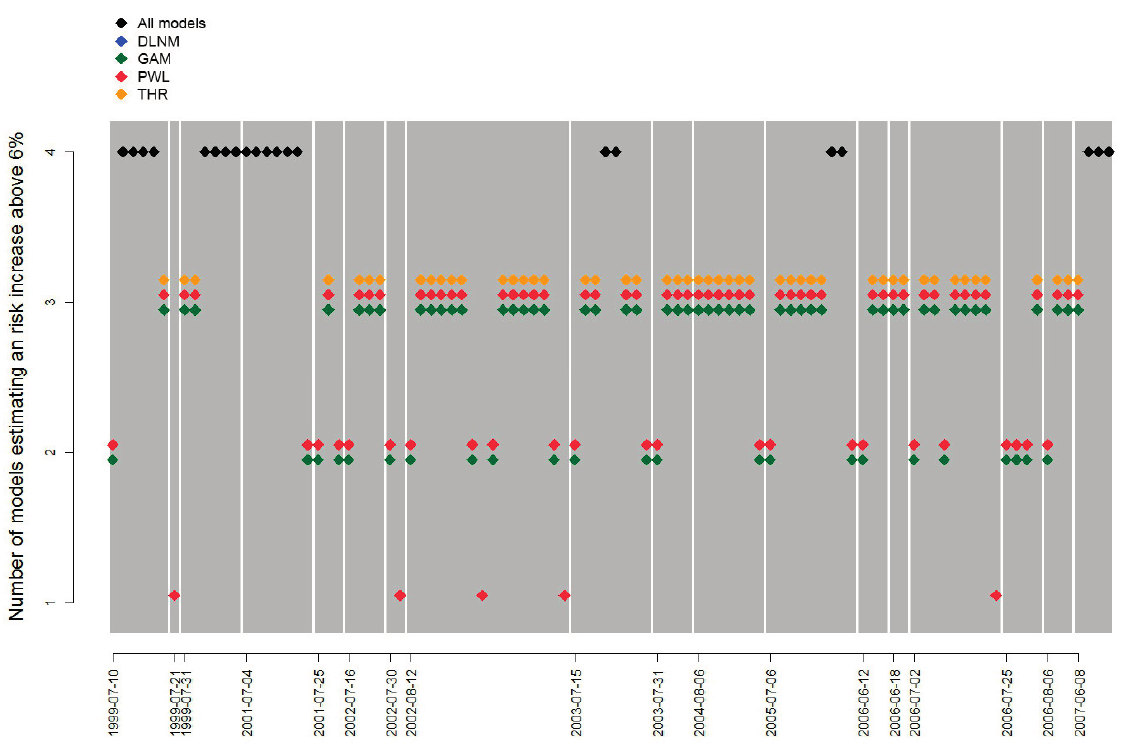
Figure 2. Comparison of which models identify heatwave days as risk days. Each grey area represents a period where risk days were identified. The markers describe which models classified each day as a risk day. The date on the x-axis describes the first day of each period with elevated mortality risk.